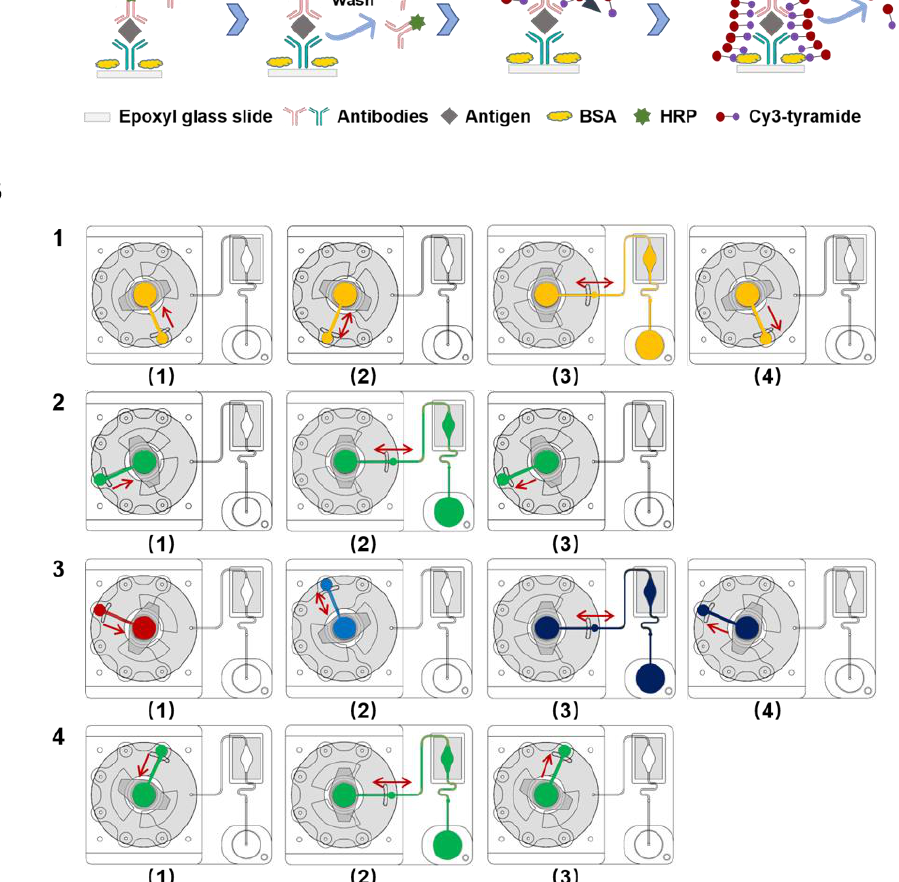
Figure 3. The cassette processing protocol. ( A ) Schematic showing the process of the immunoassay. ( 1 ) Antibody–antigen reaction; ( 2 ) washing; ( 3 ) horseradish peroxidase (HRP)-catalyzed signal amplification; ( 4 ) washing. The Cy3-tyramide molecule can be catalyzed by HRP under a H 2 O 2 environment, and the activated tyramide can covalently bind to certain amino acid residues of the proximate proteins. ( B ) Illustration of the entire flow control system of the cassette: ( 1 ) the 200 µ L serum sample is mixed with lyophilized antibody and then placed into the reaction chamber; ( 2 ) after completing the antibody–antigen reaction, the glass is washed with 800 µ L washing buffer; ( 3 ) 200 µ L TSA reagent A and 200 µ L TSA reagent B are mixed prior to transfer into the reaction chamber; ( 4 ) the glass is washed with 800 µ L washing